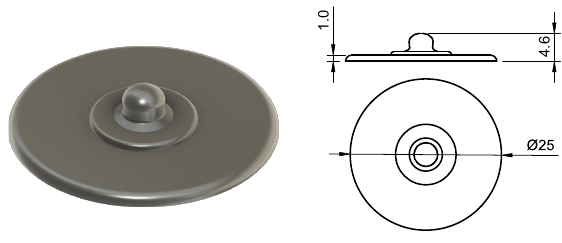
Figure 3. CAD drawing and dimensions of the snap electrode.